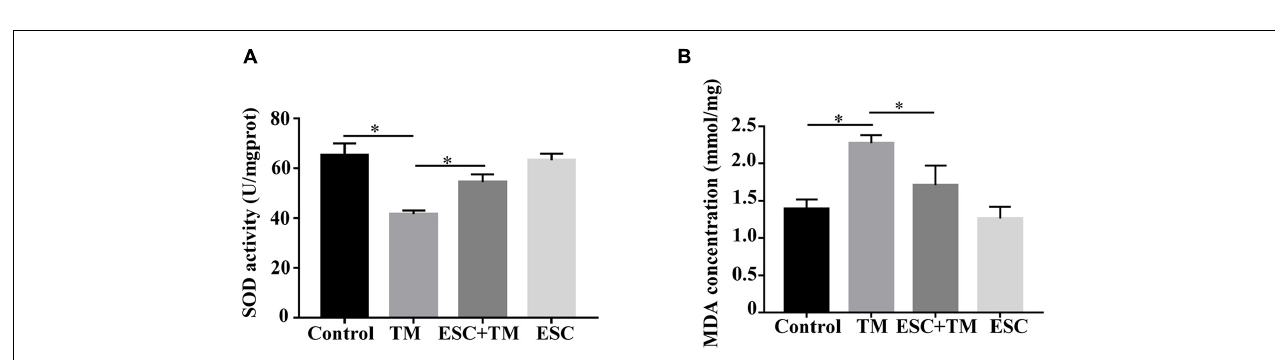
FIGURE 4 | Effect of escitalopram (ESC) on the expression of MMP9, eNOS uncoupling and Ca 2 + /CaMKII in bEnd.3 cells. (A) Western blot analysis of p-eNOS, CaMKII, P-gp and MMP9 expression after tunicamycin (TM) and ESC treatment in bEnd.3 cells. β -actin served as control. (B) Effect of ESC on the level of Ca 2 + in bEnd.3 cells. The level of Ca 2 + was determined using Fluo-3AM fluorescent probe under a fluorescence microscopy (400 × ). (C) Effect of ESC on the level of NO in bEnd.3 cells. The production of NO was measured using DAF-FM DA fluorescent probe (400 × ). The mean fluorescence intensity was computed by using ImageJ (v1.8.0.112). * p < 0.05. ** p < 0.01. Results were shown as the mean ± SD.